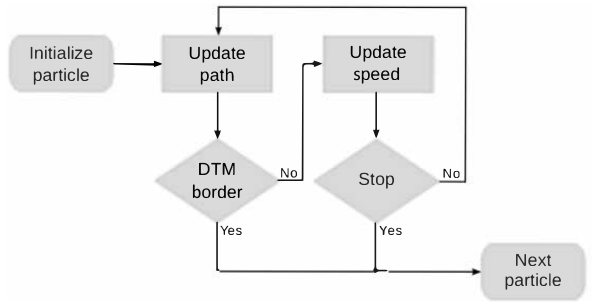
Figure 1. Flowchart of a basic GPP model configuration for mod- eling on a regional